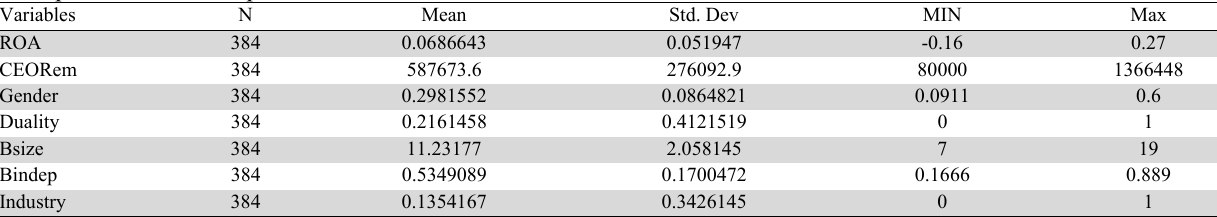
Descriptive statistics and parametric tests M2 model